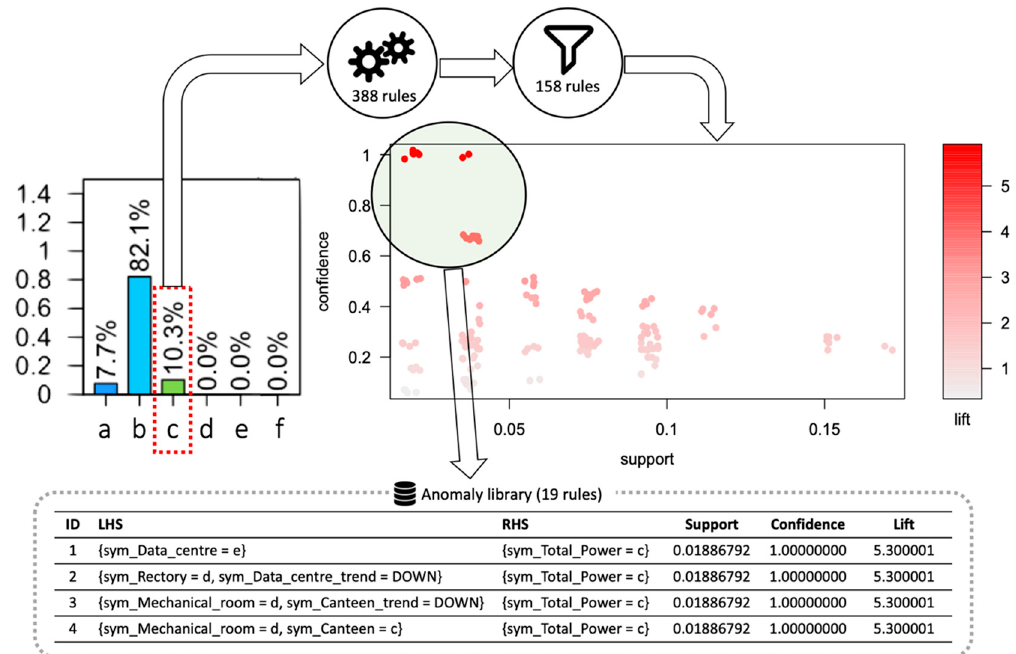
Figure 13. Diagnosis procedure of extracting, filtering, and selecting only relevant association rules from node five of the second time window.